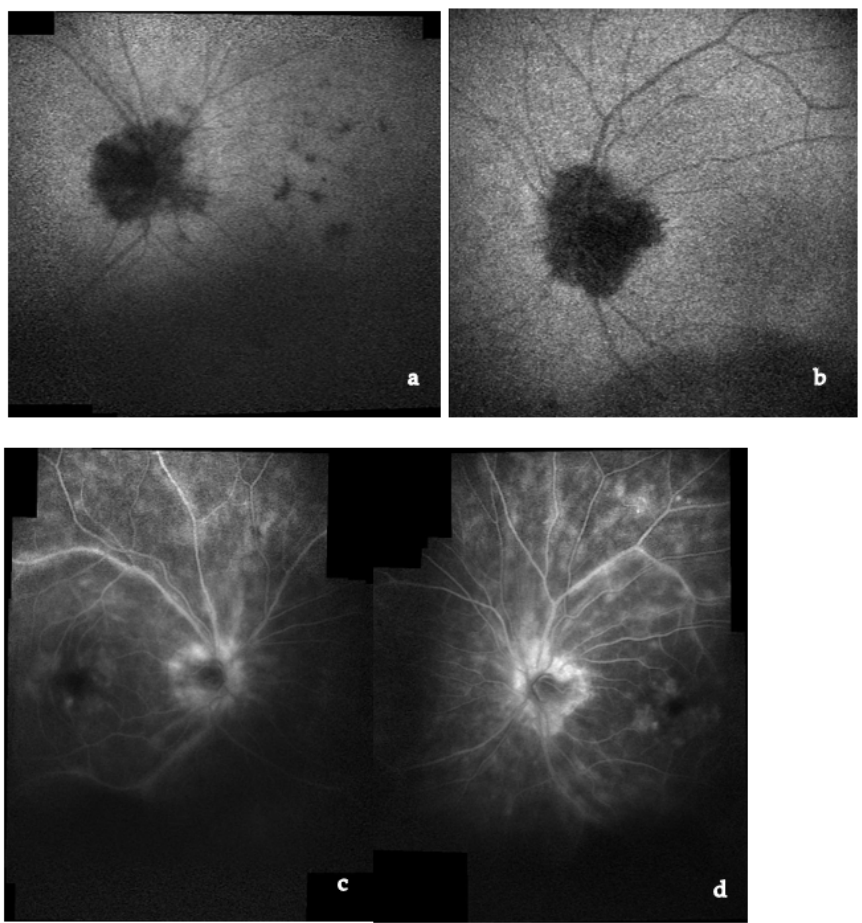
Figure 17. Ocular imaging of a 64-year-old male patient affected by CNS and bilateral optic disc sarcoid inflammation. ICGA late phases ( a , b ). FA ( c , d ) showing late dye diffusion mainly from the papillary area where granulomas are located; CME and typical segmental vasculitis are also visible.